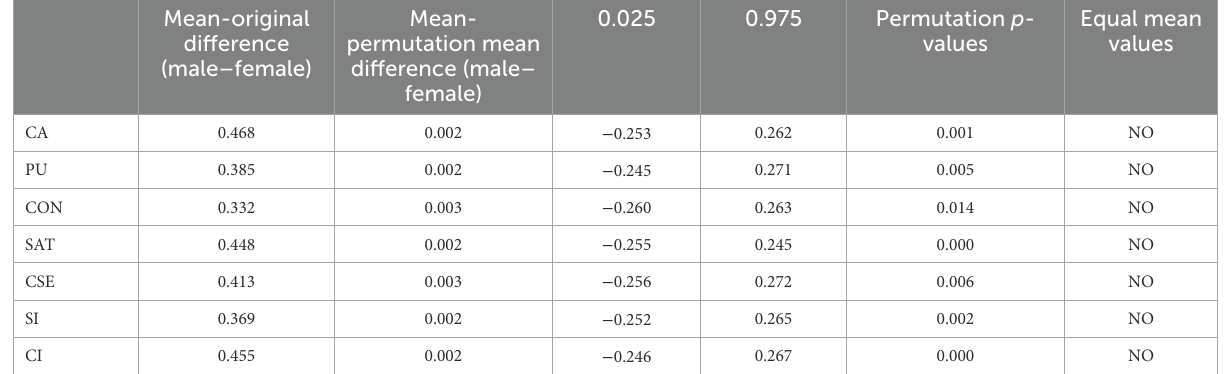
TABLE 12 MICOM Step 3 results report—part